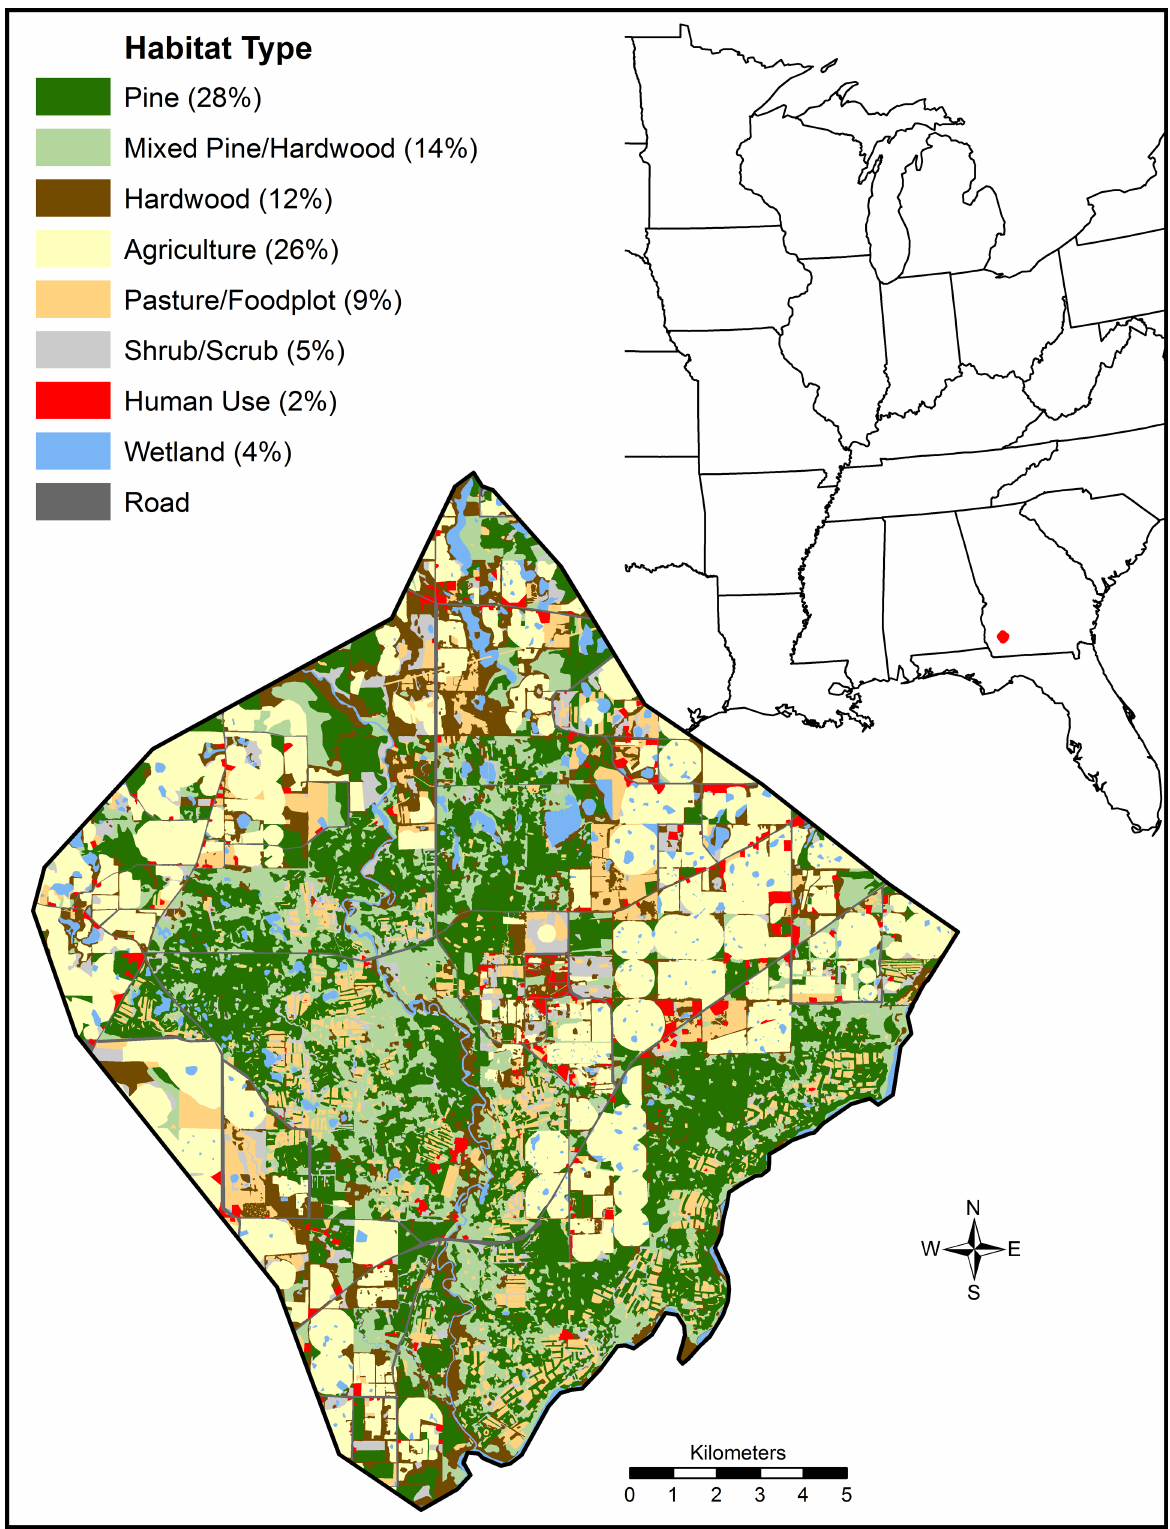
Fig 1. Location, spatial arrangement, and percentage of vegetation types in Southwestern Georgia, USA at a site used to study gray fox habitat selection from February 2014 to December2015.